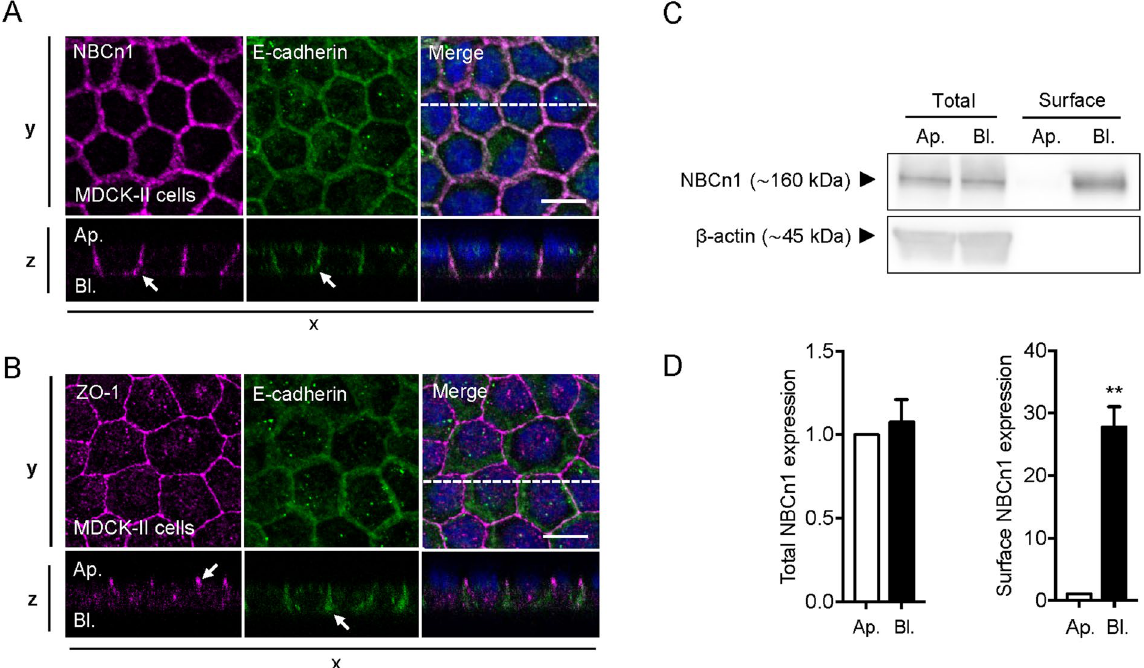
Figure 1. NBCn1 localizes to the basolateral membrane in polarized MDCK-II cells. MDCK-II cells were cultured on Transwell filters for 4 days to allow polarization ( A – D ). Cells were lysed and processed for immunofluorescence analysis ( A , B ) or cell surface biotinylation followed by Western blotting ( C , D ). ( A , B ) fluorescence images of NBCn1 (magenta), E-cadherin (green) and ZO-1 (magenta). Nuclei stained with DAPI (blue). Images were collected as z-stacks on a confocal microscope and shown as z-projections with corresponding xz-scans. Scale bar 10 µ m. ( C ) Representative Western blots. ß-actin was used as a loading control. ( D ) Quantification of total NBCn1 expression and NBCn1 surface expression. Values are normalized to the apical pool of NBCn1. Quantifications of Western blot data are shown as means with SEM error bars. ** indicate P < 0.01. Student’s t test. Data are representative of 3 independent experiments. Ap.: apical; Bl.: